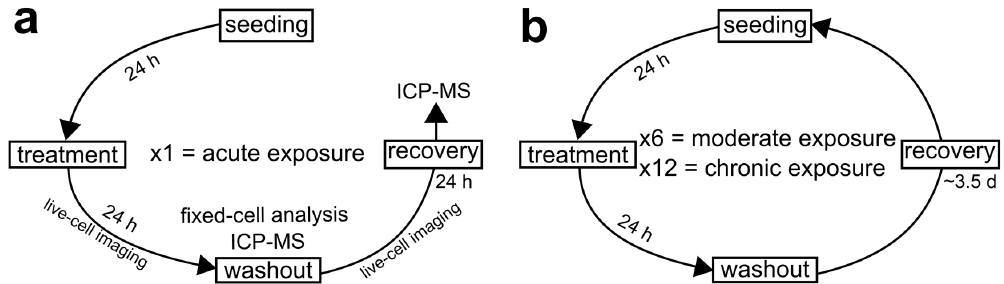
Figure 1. Diagrammatic representation of the experimental design conceived for the present study. ( a ) Experimental scheme for acute AgNP exposure where cells undergo one, 24 h AgNP treatment. ( b ) Experimental scheme for moderate and chronic AgNP exposure. For these prolonged exposures, acutely treated cell populations were maintained in culture and repeatedly exposed to AgNPs. After recovery, cells were passaged and exposed to another AgNP treatment. This cycle was repeated either six times (moderate exposure) over a period of three weeks or twelve times (chronic exposure) over a period of six weeks. In all experiments, live-cell imaging was performed in cells undergoing the last treatment cycle and during the 24 h following washout. Moreover, fixed-cell analysis was performed at the end of the last treatment cycle.